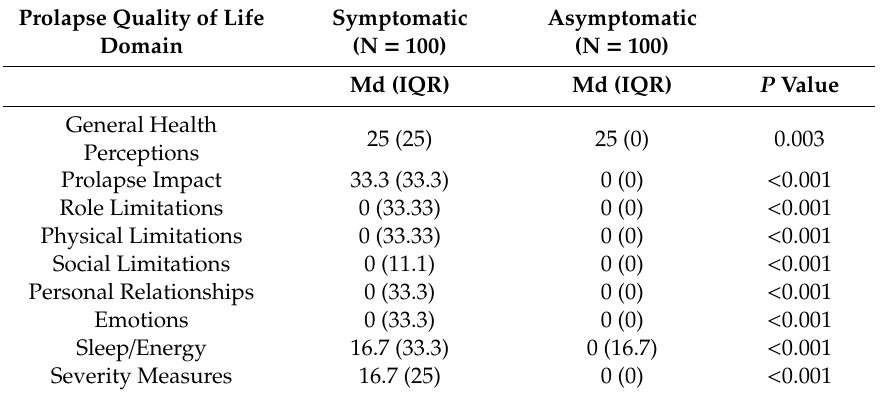
Table 3. Discriminative validity. Correlation of P-QoL domains scores between symptomatic and asymptomatic women by Mann–Whitney